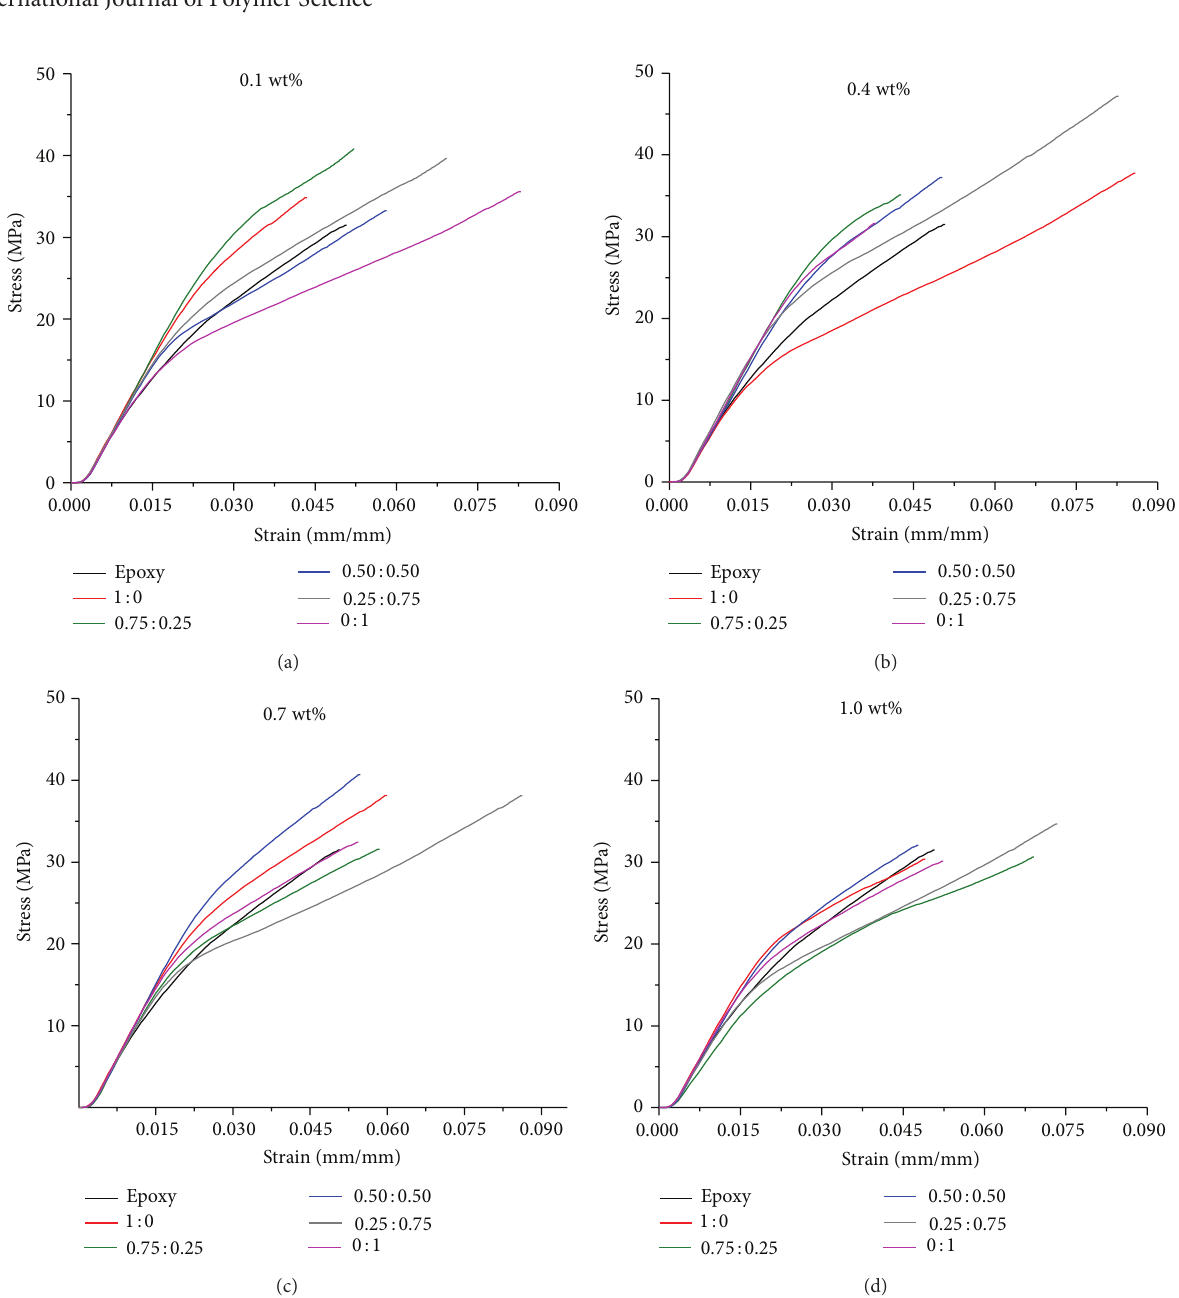
Figure 4: Stress-strain curves for nanocomposites at different loads and